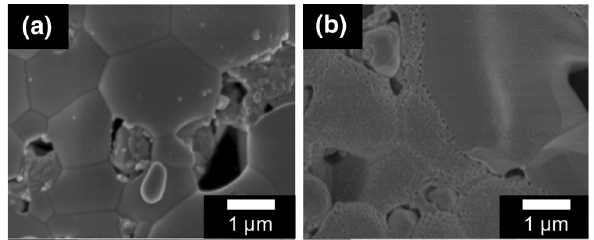
Fig. 7 Secondary electron image showing the symmetric anode structure in plan view ( a ) before and ( b ) after 8 infiltration printing passes. The infiltrated sample had a high density of CGO nanopar- ticles decorating the surface